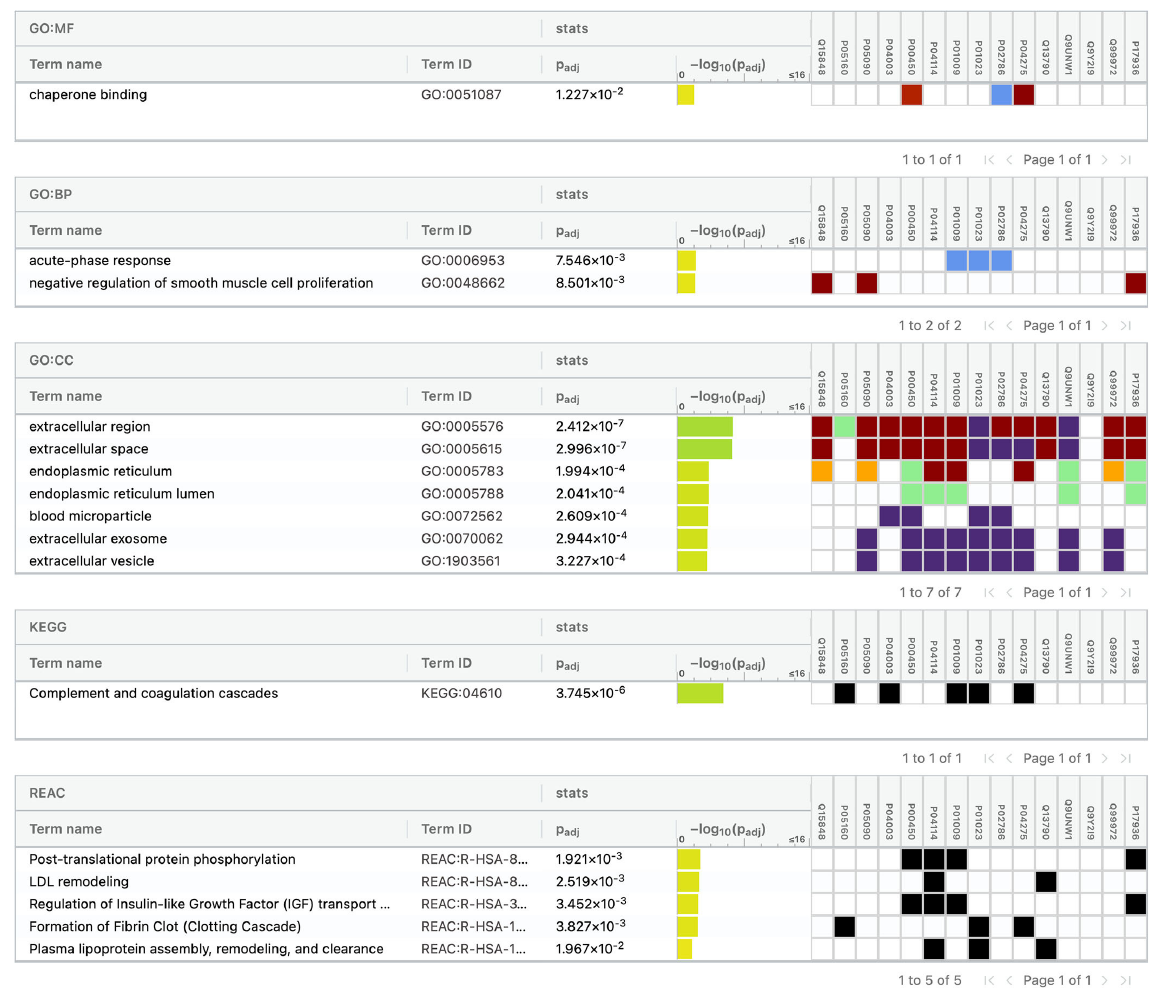
FIGURE7 Functional enrichment analysis of differentially expressed proteins between ischemic stroke and healthy